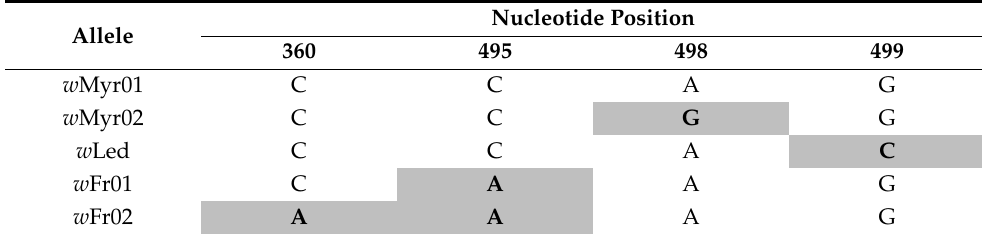
Table 3. Variable sites of the studied Wolbachia wsp gene fragment among the 34 samples sequenced.